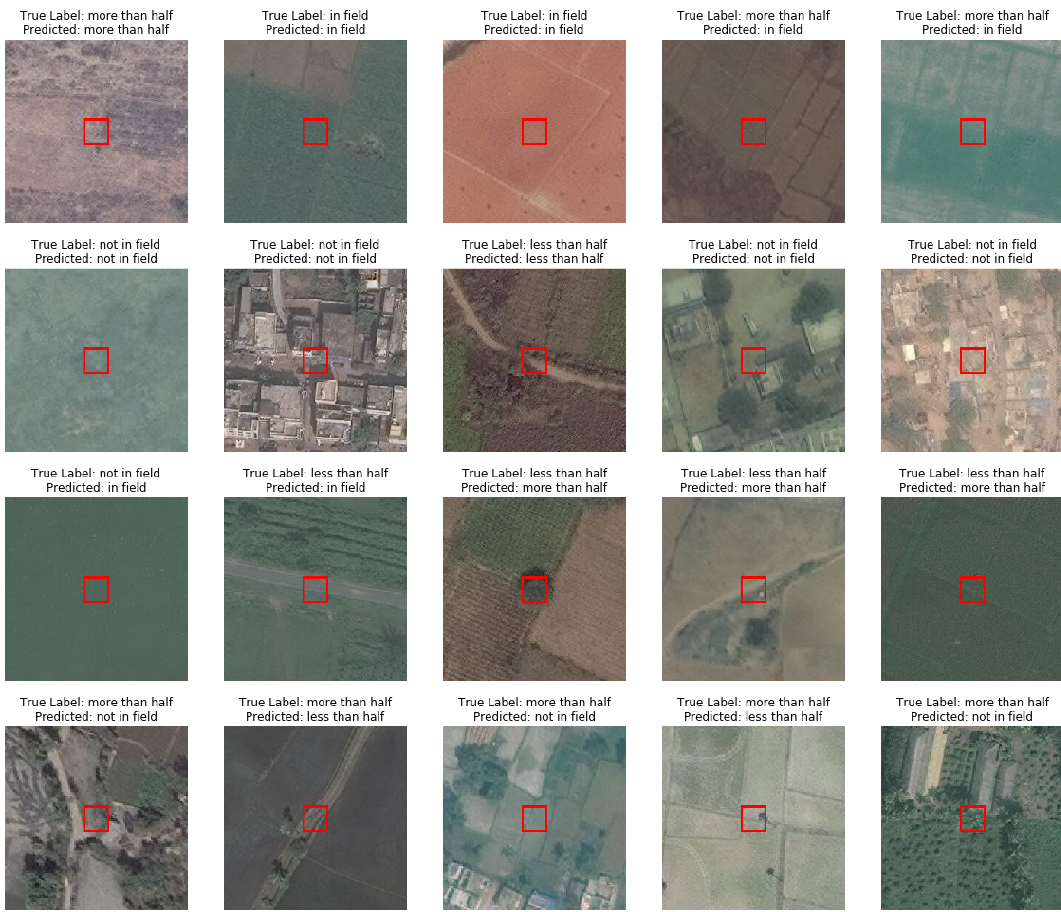
Figure A7. From first row to last row: true positives, true negatives, false positives, and false negatives of the binary in-field classification problem. Five examples were sampled at random from each category. The box marks the size of a Sentinel-2